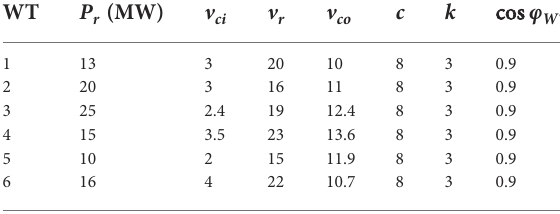
TABLE 2 Parameters of WTs.